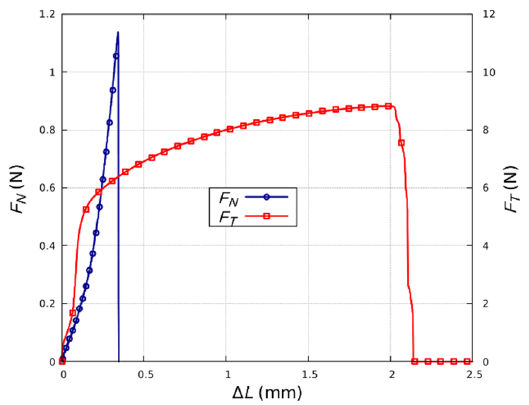
Figure 11. Results of strength testing joints for the tangential component F T and the normal force component F N .